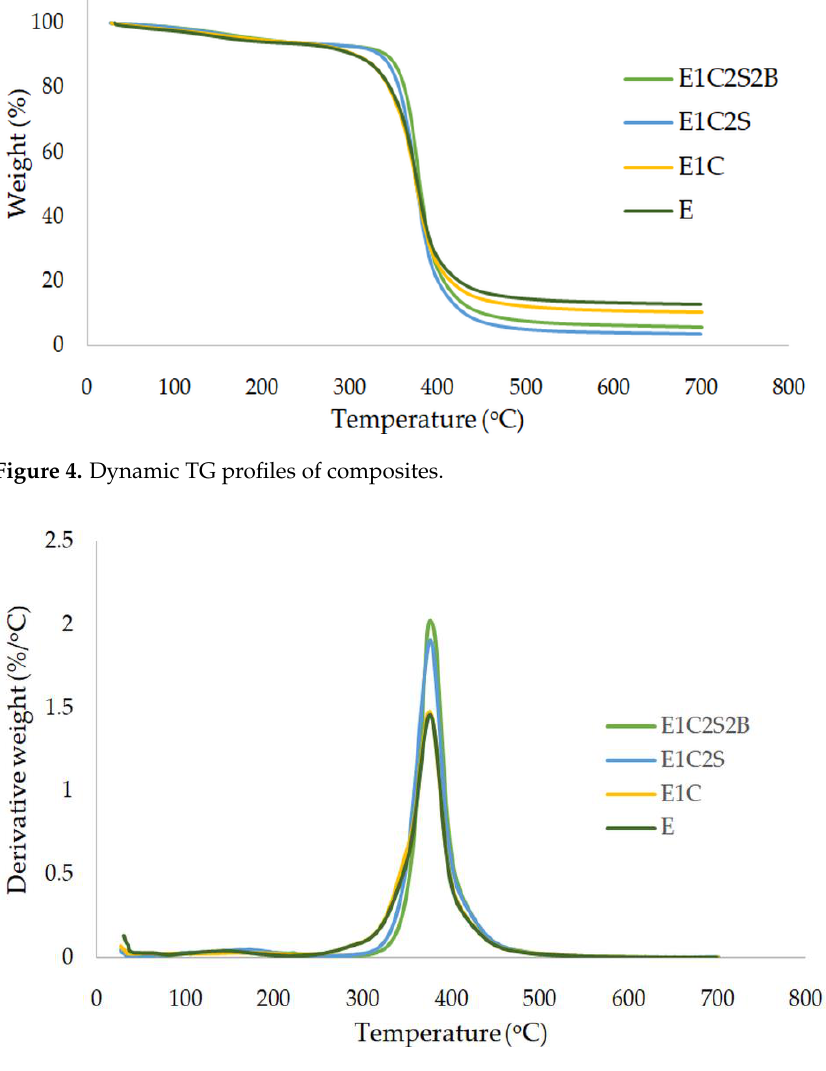
Figure 5. Derivative thermogram of